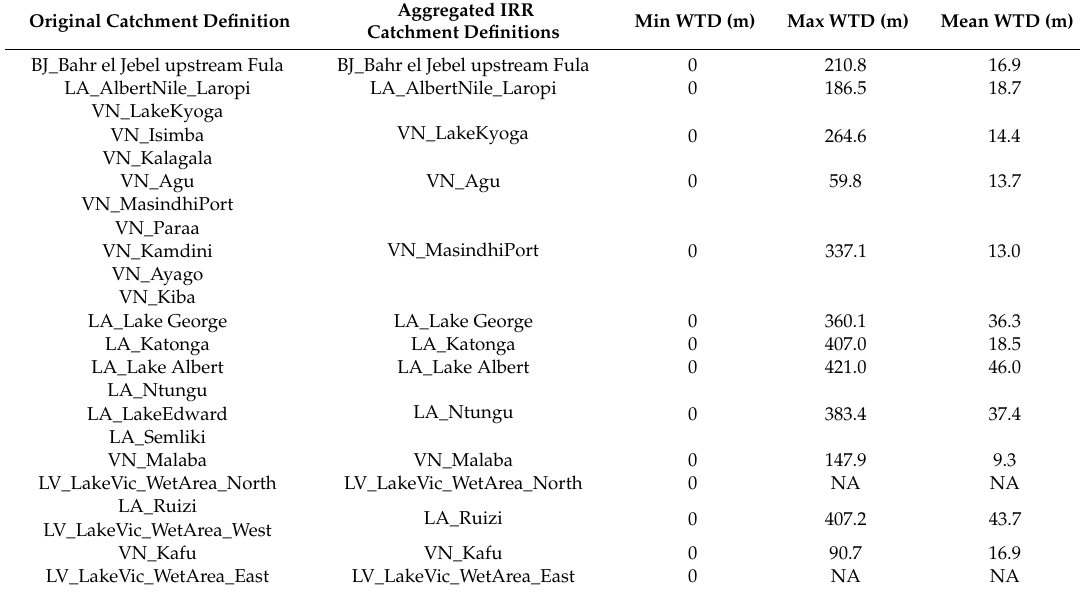
Table A5. Catchment specific water table depths (WTD)